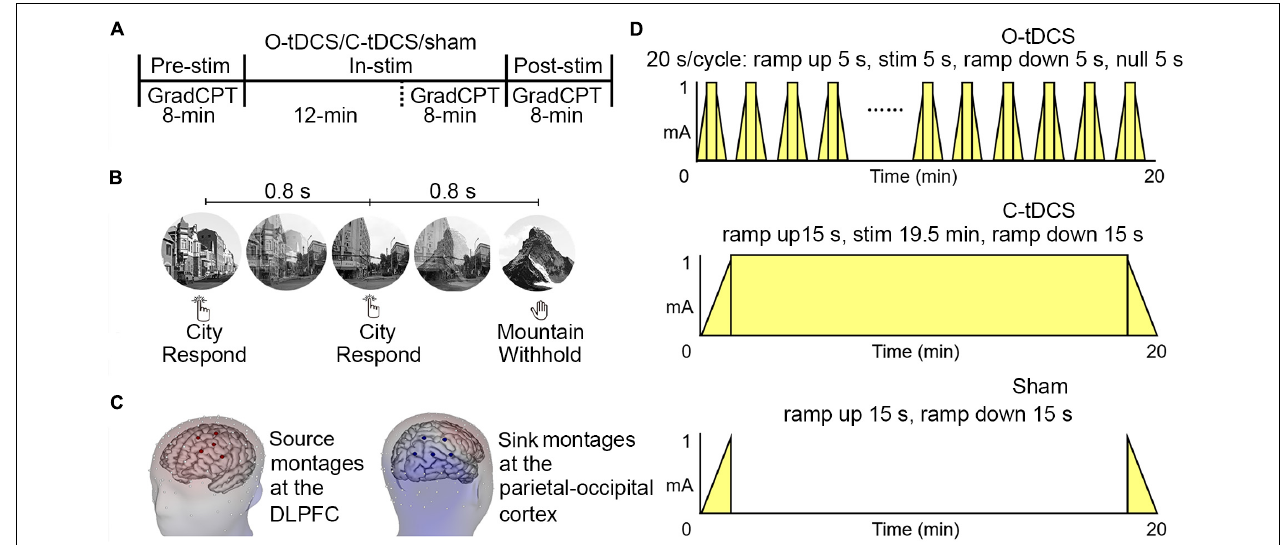
FIGURE 1 | The illustration of experimental procedure. (A) Stimulation procedure. Each stimulation condition consists of three phases, namely, pre-stim, in-stim, and post-stim. The gradual-onset continuous performance task (GradCPT) is performed once in each phase. (B) GradCPT program. The scenes were randomly presented with 90% city (i.e., the go stimulation) and 10% mountain (i.e., the no-go stimulation). The gradual transition of one image to another used the linear pixel-by-pixel interpolation, where the complete transition occurred over 800 ms. (C) Stimulation location. The source montages were placed over the left dorsal lateral prefrontal cortex (corresponding to AF3, F1, F3, F5, and FC3 of the 10–20 EEG system), while the sink montages were placed over the right-back of the head (corresponding to CP4, CP6, P2, P4, and PO4 of the 10–20 EEG system). (D) Stimulation protocol. Each stimulation condition lasts for 20 min with different patterns of ramp-up, stimulation, and ramp